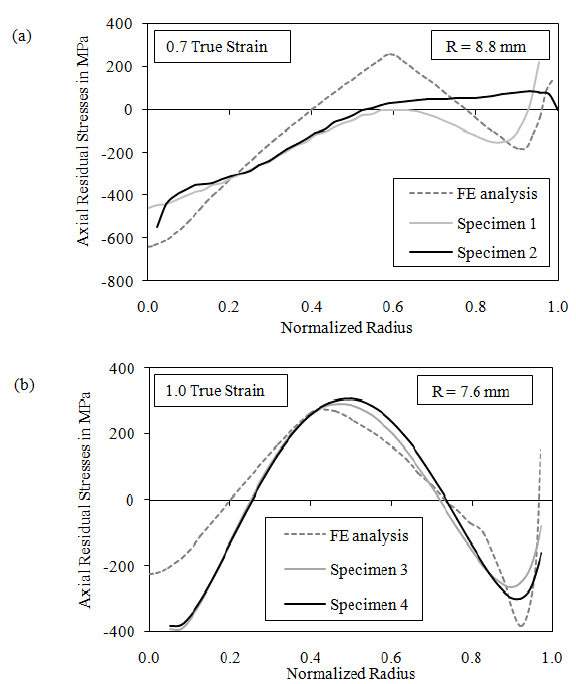
Figure 9. The distribution of axial residual stress according to full extrusion FEA in Abaqus®